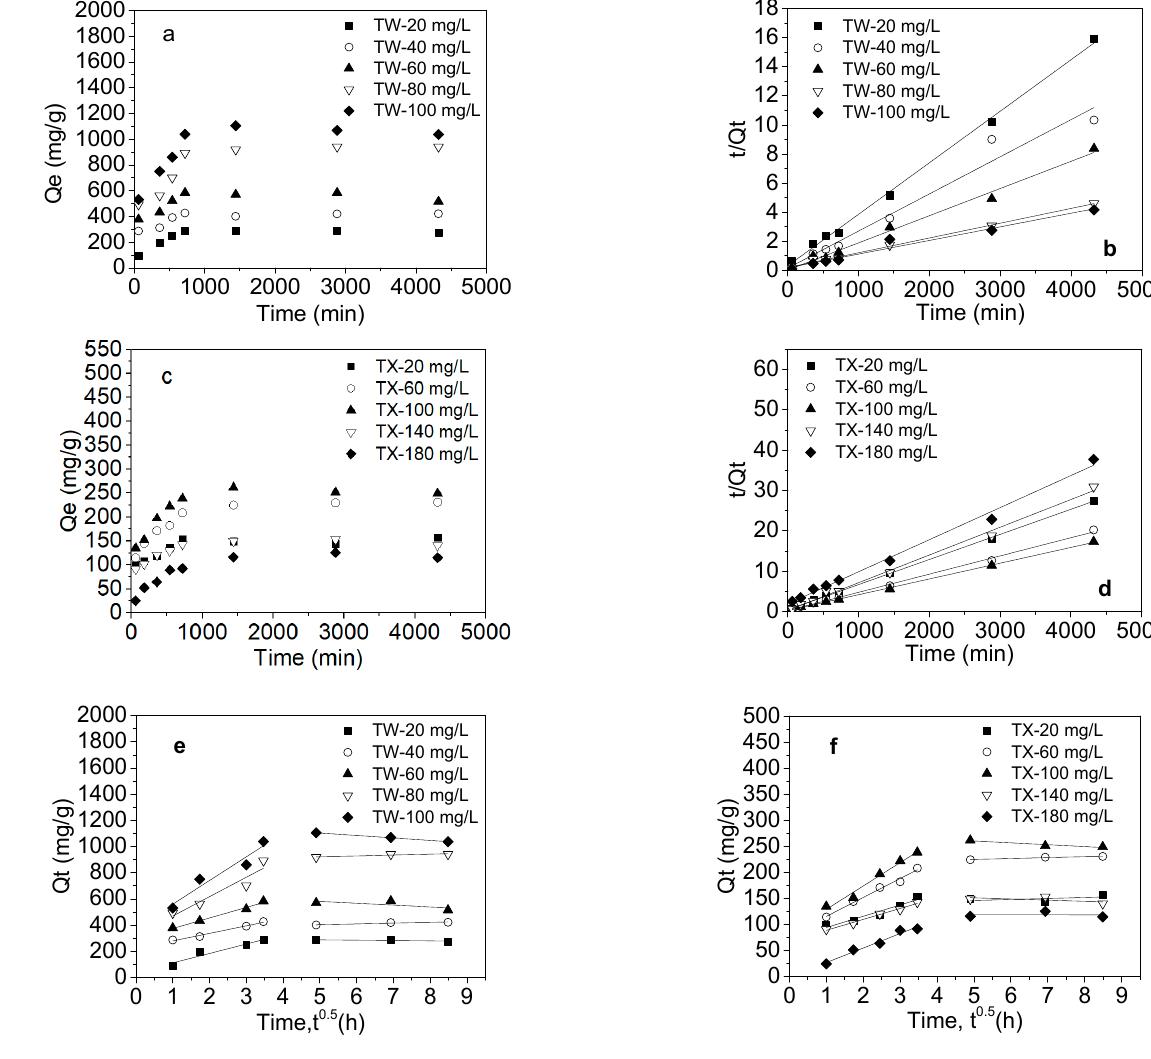
Figure 1. Adsorption kinetics of nonionic surfactants onto MWCNTs ( a , c ), pseudo-second-order model fitting ( b , d ), and Weber – Morris model fitting ( e , f ). Table 1. Parameters of pseudo-first-order and pseudo-second-order model and Weber – Morris model for adsorption kinetics of nonionic surfactants onto MWCNTs.